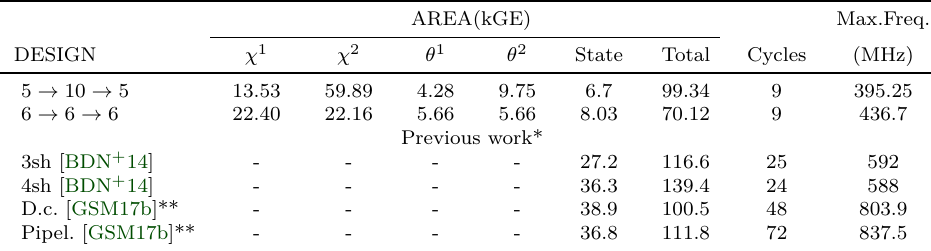
Table 2: Keccak - f [200] first-order secure unrolled implementations’ performance results using NanGate 45nm library. Comparison with Parallel implementations from [BDN + 14] and PARALLEL double clocked and PARALLEL pipelined from [GSM17b] AREA(kGE) Max.Freq.